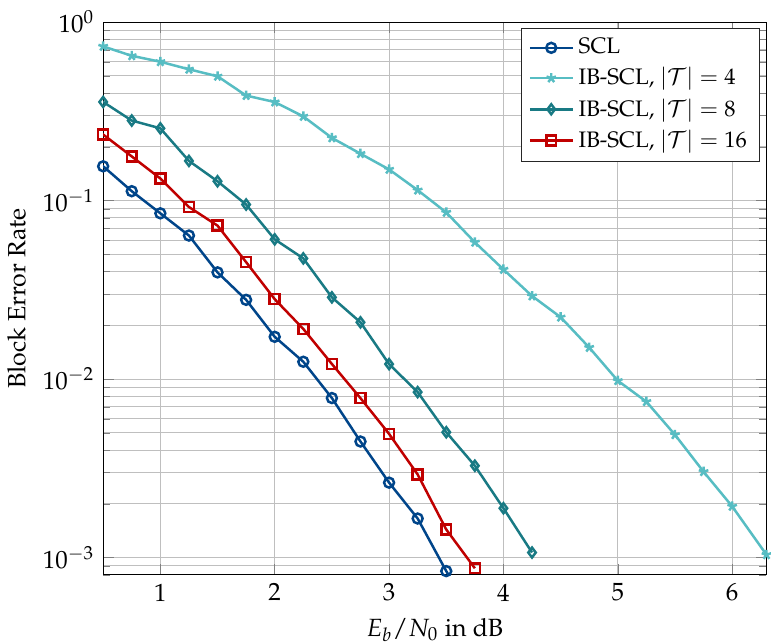
Figure 19. Block error rate comparison between conventional decoder (SCL) and information bottleneck decoders (IB-SCL) constructed for |T | = 4,8 or 16. N = 256, N L = 32, no CRC, code rate 37/256, and design E b / N 0 = 4 dB.